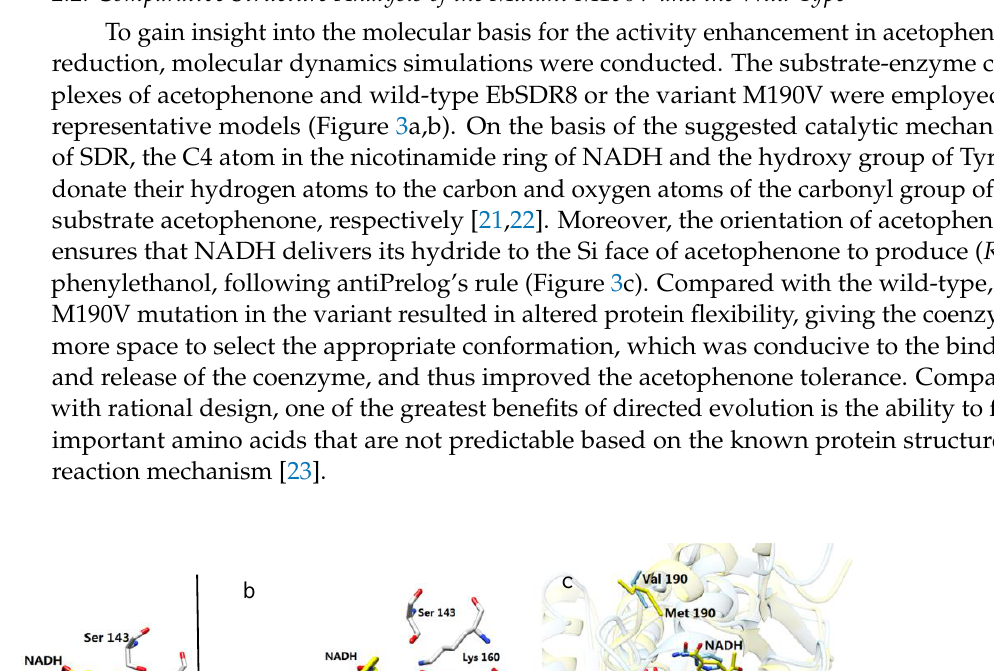
Figure 2. The specific activity of the wild-type and the mutants of M190X measured with purified proteins. Reaction conditions: 500 μL reaction media consisting of sodium phosphate buffer (100 mM, pH 7.5) and 50 μL pure protein, 5 mM NADH, 1% isopropanol, 200 mM of acetophenone, 30 o C, and 10 min. Error bars indicate the standard deviation. Table 1. Apparent kinetic parameters of the wild-type and the mutant M190V.